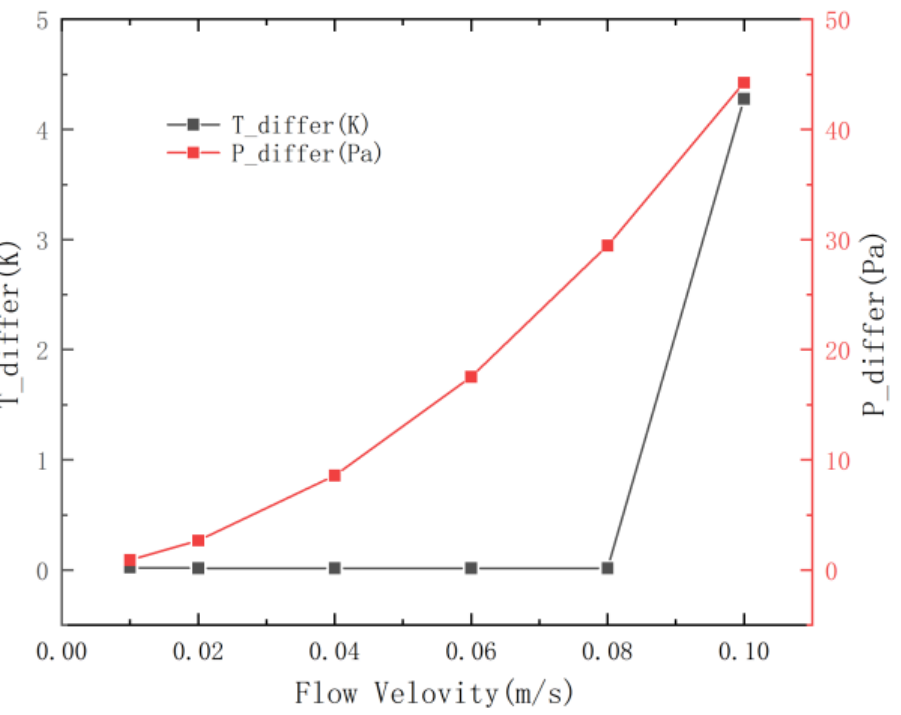
Figure 8. Effect of flow rate on the temperature difference and pressure difference.